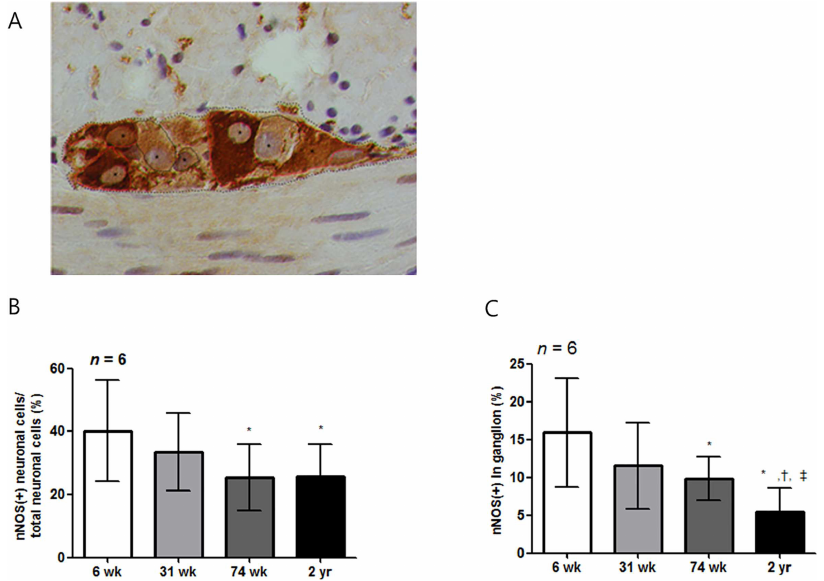
Fig 7. The enumeration of neuronal cell in myentericganglia. (A) gangliain the myenteric plexus were micro graphedat x1,000. We enumerated the nNOS-positive (indicated with red line) or -negative(indicated with black line) myentericneurons, which includenucleus(indicated with asterisk), in the ganglion (contours of the ganglion are indicatedby dashedlines). (B) The percent of nNOS positive neuronalcells of total neuronal cells in ganglionof 74-wk-oldand 2-yr-old rats was significantly lower than that of 6- and 31-wk-oldrats ( P = 0.002, 6-wk- vs . 74-wk-oldrats; P = 0.002, 6-wk- vs . 2-yr-old rats; P = 0.041, 31-wk- vs . 74-wk-oldrats, and P = 0.019, 31-wk- vs 2-yr-old rats). (C) Mean of proportionof nNOS-immunoreactive area in ganglionwas also decreasedas age increased( P = 0.020, 6-wk- vs . 31-wk-oldrats; P = 0.001, 6-wk- vs . 74-wk-oldrats; P < 0.001, 6-wk- vs . 2-yr-old rats; P < 0.001, 31-wk- vs . 2-yr-old rats, and P < 0.001, 74-wk- vs 2-yr-old rats). Each bar represents the mean ± SE. * P < 0.05 comparedwith 6 wk of age; † P < 0.05 comparedwith 31-wk of age; ‡ P < 0.05 comparedwith